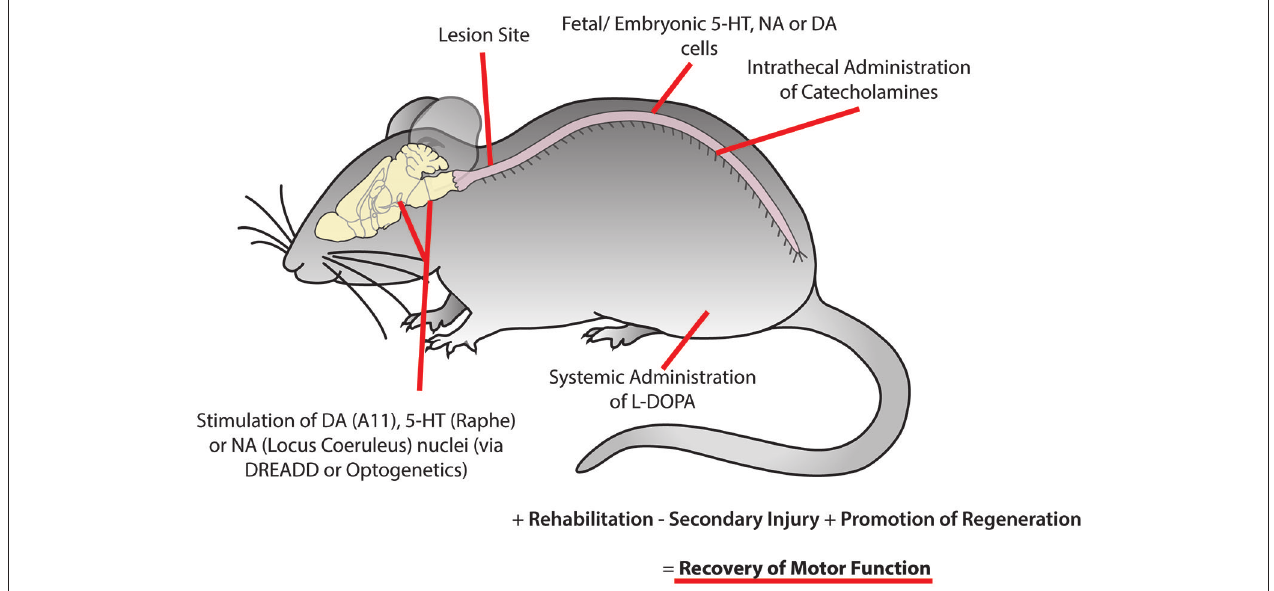
serotonergic raphe nucleus caudal to the site of injury, intrathecal injection of catecholamines and systemic injection of L-DOPA. While these approaches may not be optimal in isolation, they may serve as an effective complementary treatment with rehabilitation and other therapies to reduce secondary injury and promote regeneration of damaged descending tracts to promote the recovery of motor